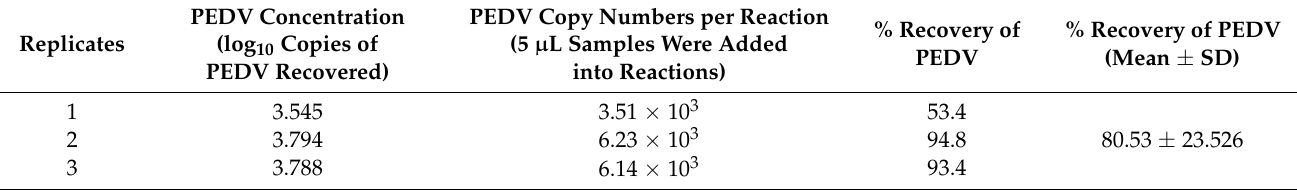
Table 2. Recovery efficiency of the ultrafiltration method using PEDV as a